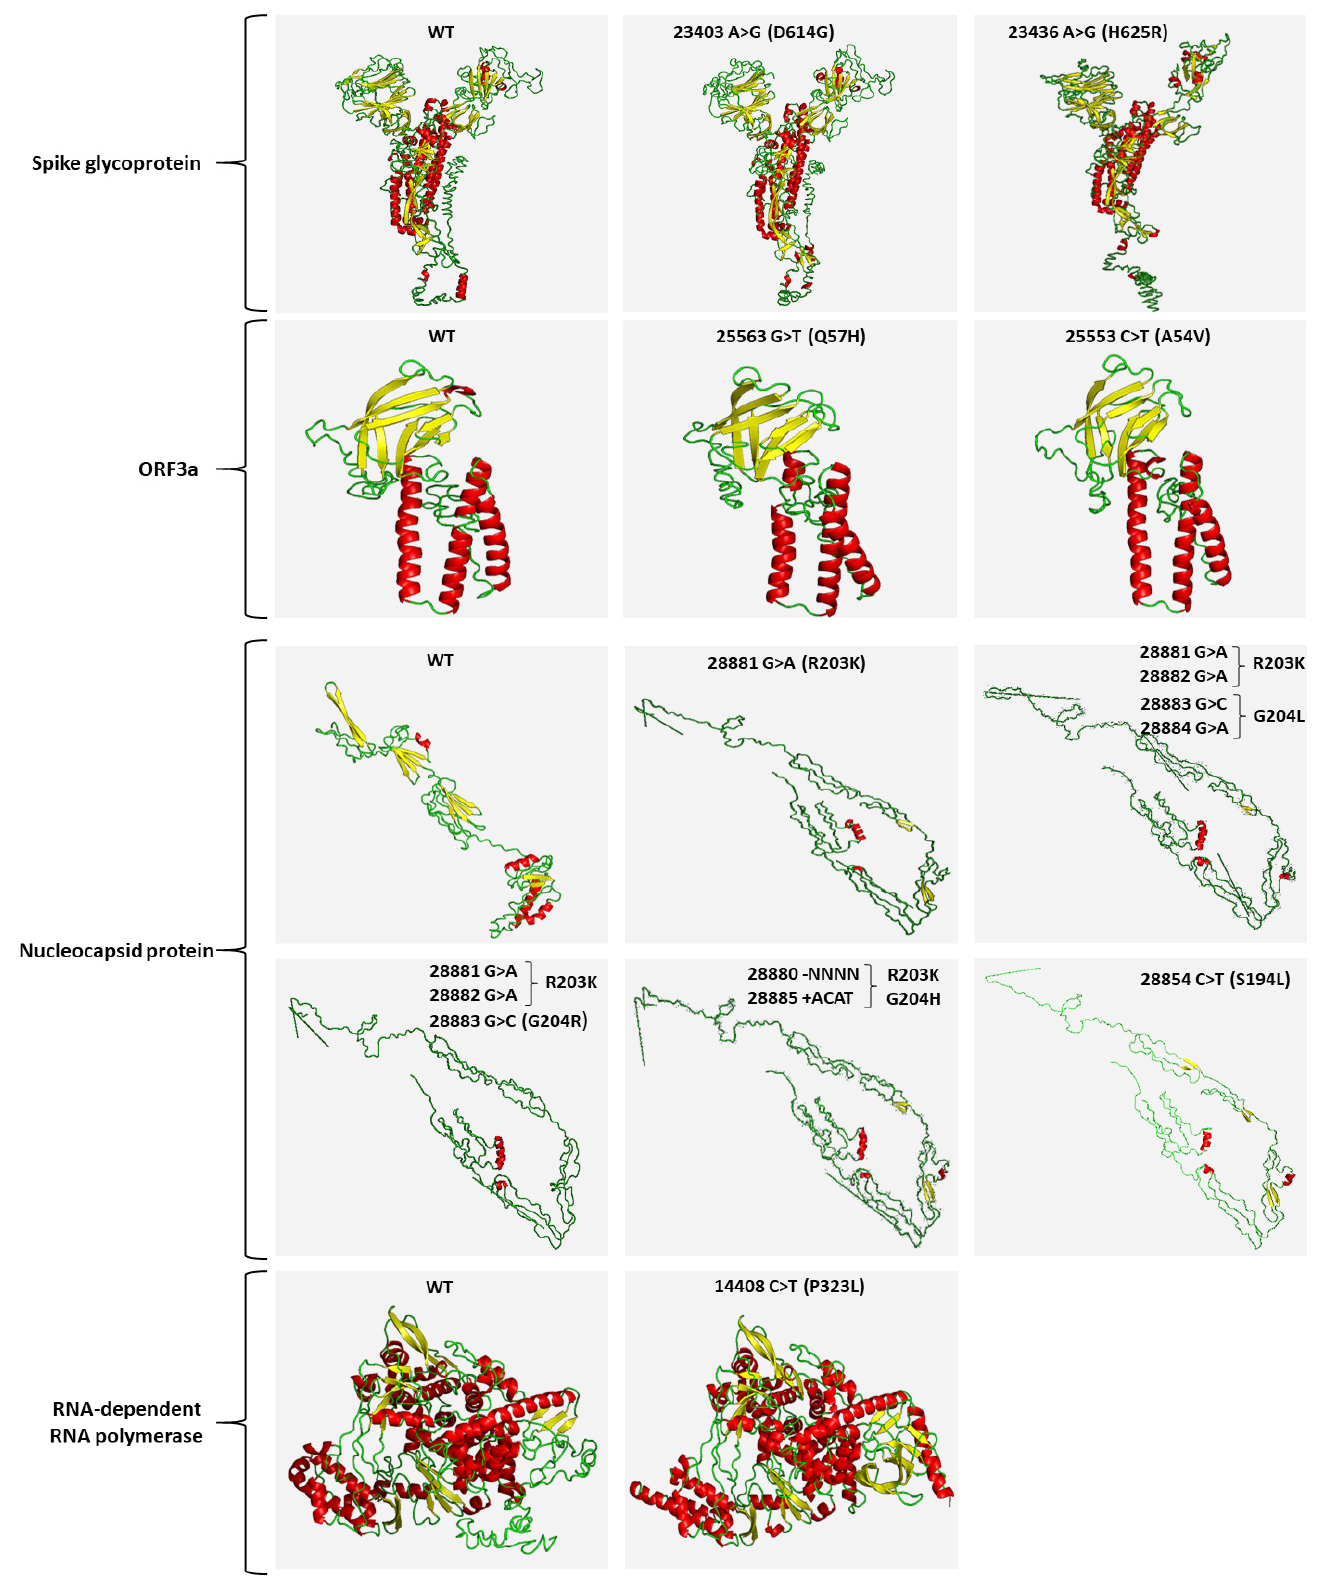
Figure 5. Predicted 3D structure models of “wild-type” and mutated SARS-CoV-2 proteins, using the I-TASSER v.5.1 server. For each protein, only the 3D structure with the highest confidence score is shown. Helix, sheet, and loop structures for each protein are depicted with red, yellow, and green colors, respectively.